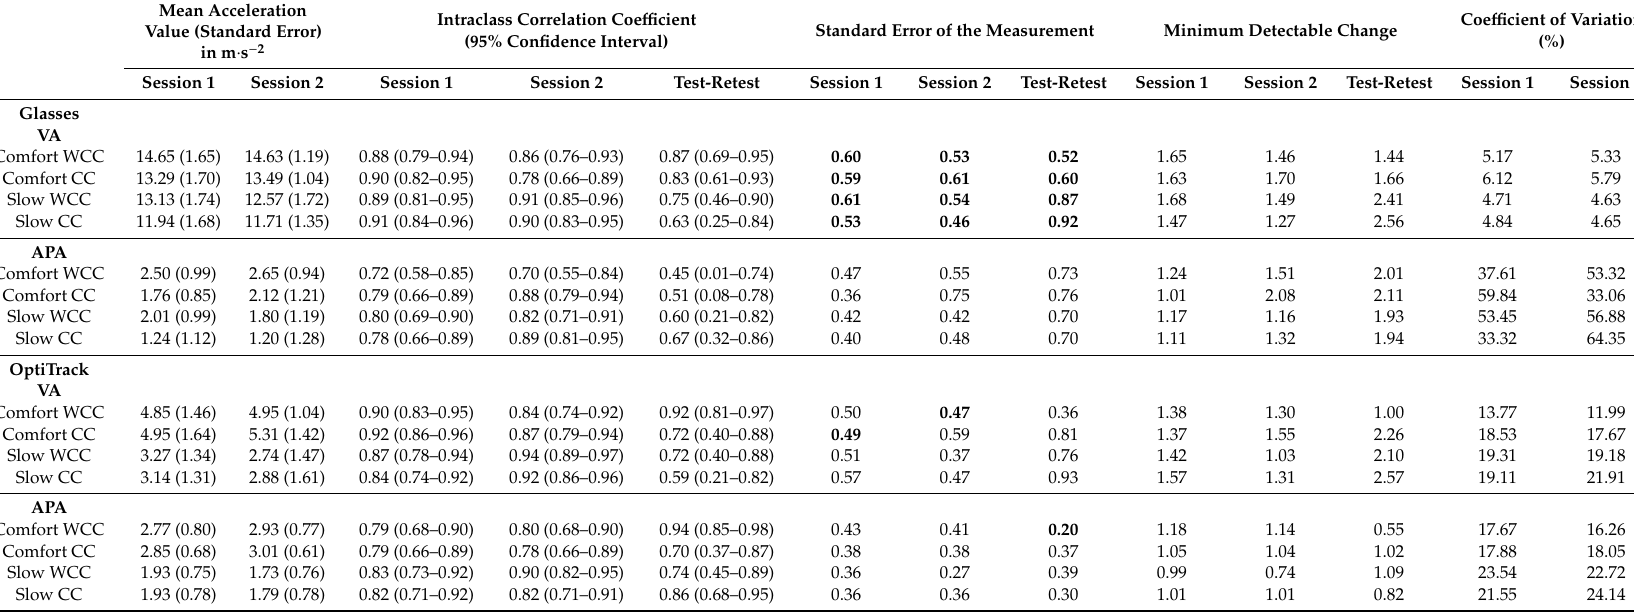
Table 1. Mean acceleration values, intraclass correlation coe ffi cient (95% confidence interval), standard error of the measurement, minimum detectable change and coe ffi cient of variation (%) measured with the eyeglasses and the kinematic system (OptiTrack) during fifteen sit-to-stand movements for both